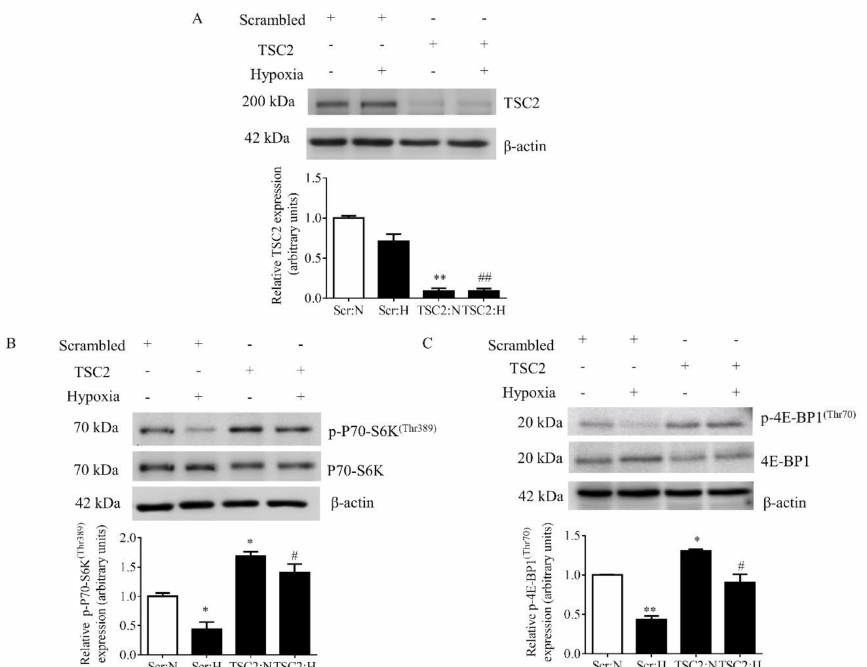
Figure 6. The effect of TSC2 silencing in hypoxia on mTORC1 functional readouts in decidualized primary HESCs. Decidualized primary HESCs were transfected with TSC2 or Scramble (Scr) siRNA, and then cells were cultured in normoxia (N) (incubator air) or in hypoxia (H) (1% O 2 ). Representative Western blots validate successful knock down of TSC2 ( A ) and depict the levels of phosphorylation of mTORC1 functional readouts: p-P70-S6K (Thr389) ( B ) and p-4E-BP1 (Thr70) ( C ). Equal amounts of protein from cell lysates were used (30 µ g). The Western blot data are summarized in the bar graphs ( n = 4). Levels of phosphorylation were normalized to total protein then β -actin. Values are displayed as mean + SEM; * or # , p < 0.05; ** or ## , p = 0.001–0.05 versus control as per one-way ANOVA. Tukey’s multiple comparisons test. * = significant difference compared to HESCs transfected with Scr siRNA in normoxia; # = significant difference compared to HESCs transfected with Scr siRNA in